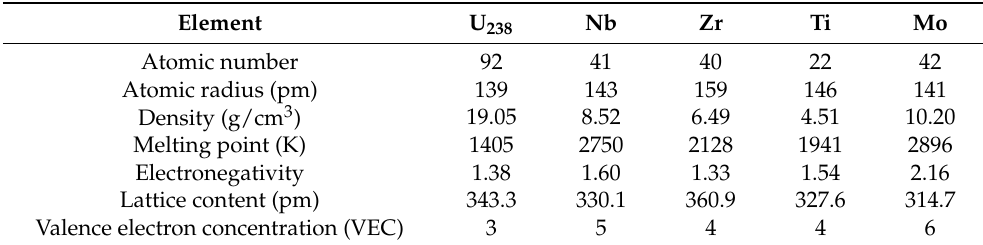
Table 2. Physical properties of each element, data from [24–26].